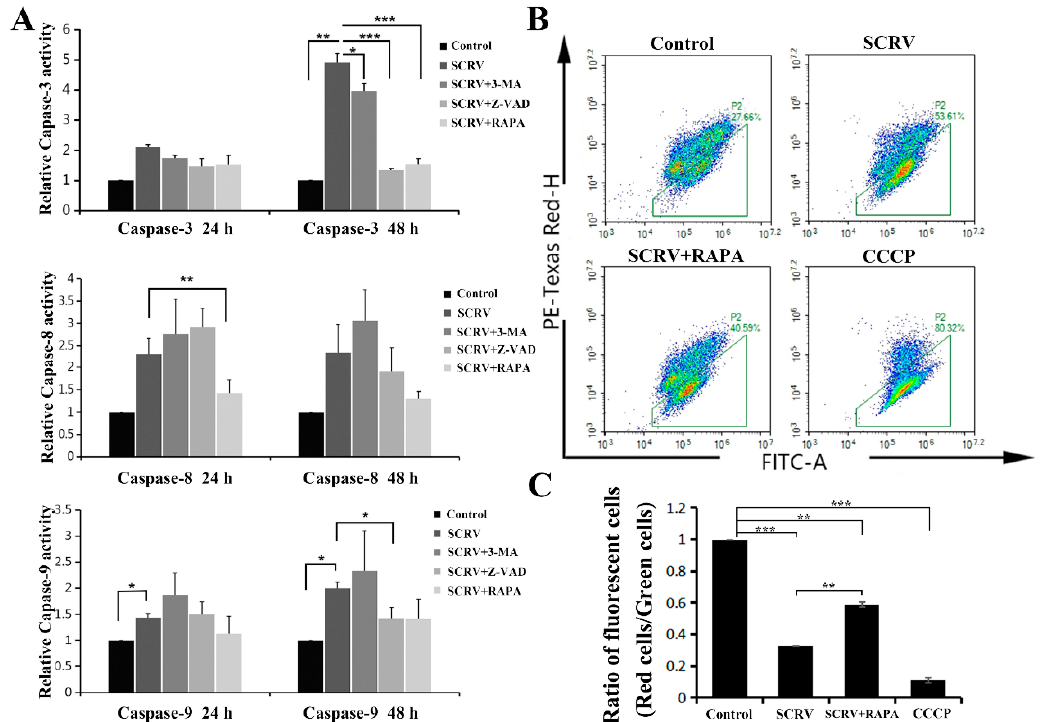
Figure 3. Effects of autophagy or apoptosis inhibitors on the SCRV-infected EPC cells. ( A ) Detection of caspase-3, -8 and -9 activities in SCRV-infected cells at 24 h and 48 h, respectively. The infected cells were co-treated with Z-VAD (100 μ M), 3-MA (5 mM) and RAPA (1 μ M), respectively. ( B ) Flow cytometry analysis of SCRV-infected cells after rapamycin co-treatment at 48 h. ( C ) Statistical analysis of ratios of fluorescent cells (red cells/green cells in Figure 3B), which suggested that rapamycin could reduce the proportion of apoptotic cells, comparing with SCRV-only infection group. p < 0.05 (*), p < 0.01 (**) and p < 0.001 (***).